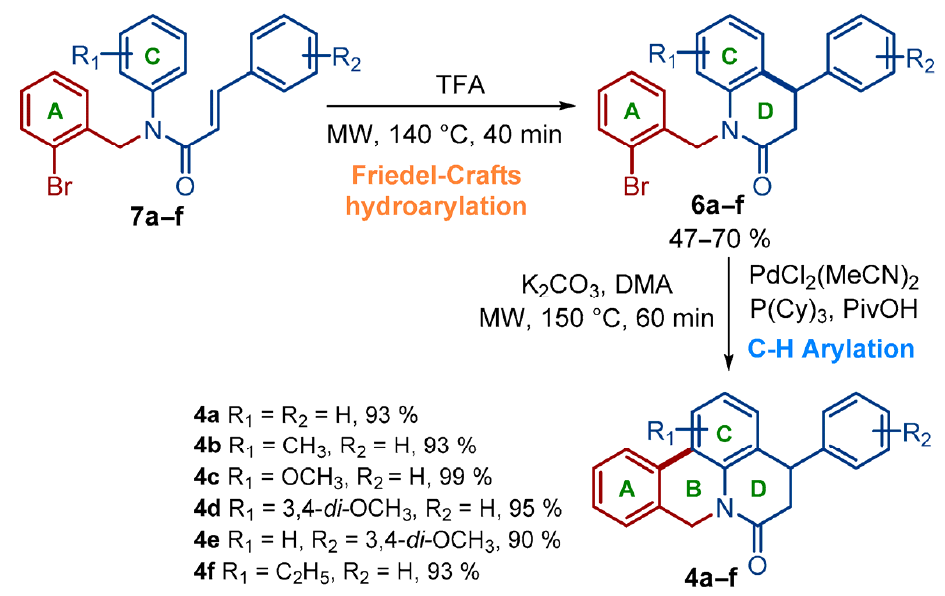
Scheme 4. Synthesis of pyrido[3,2,1- de ]phenanthridin-6-ones 4a – f via sequential intramolecular. Friedel-Crafts alkylation and direct C–H arylation.